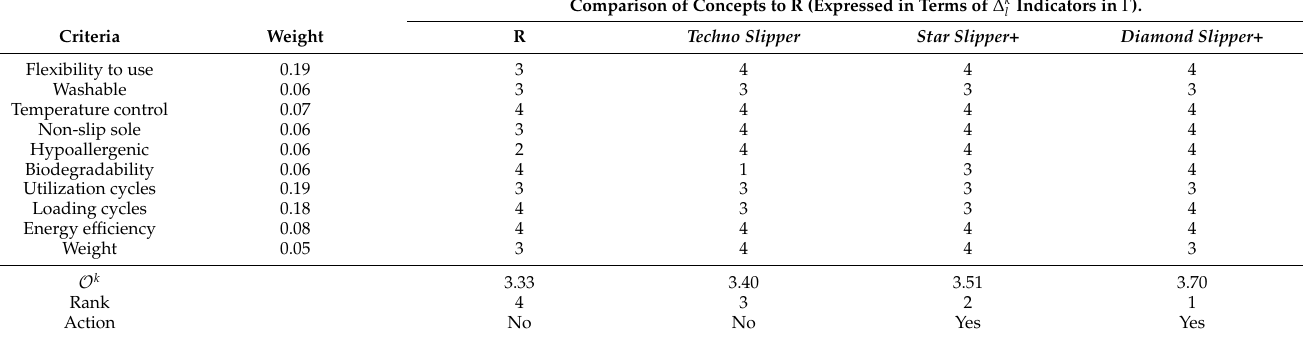
Table 18. Results of concept rating. Comparison of Concepts to R (Expressed in Terms of ∆ k l Indicators in Γ